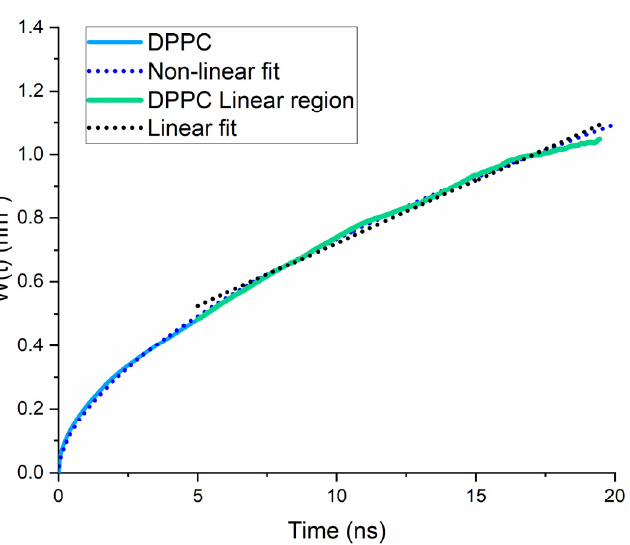
Figure 3. Simulated molecule-averaged MSD for DPPC lipids bilayers. The non-linear fit resulted from fitting to Equation (2).